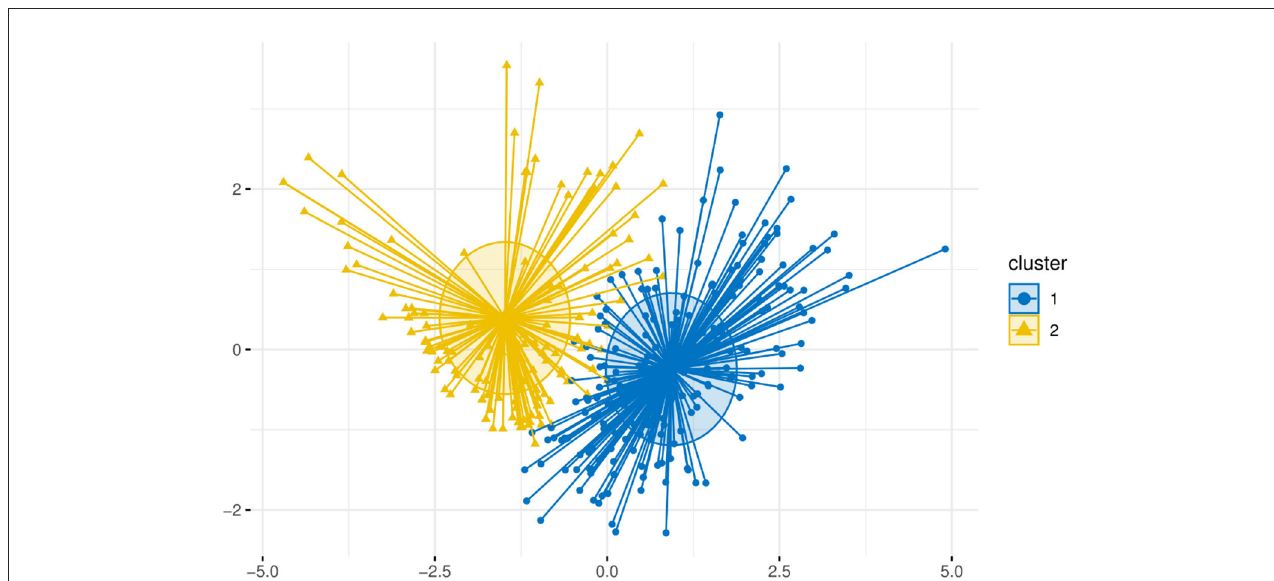
FIGURE3 K-means clustering result. Cluster 1 (n = 198) named “Low”, presented lower scores in the behavior subscale. Cluster 2 (n = 118), assigned as “High”, scored higher on all dimensions of behaviors associated with ITP